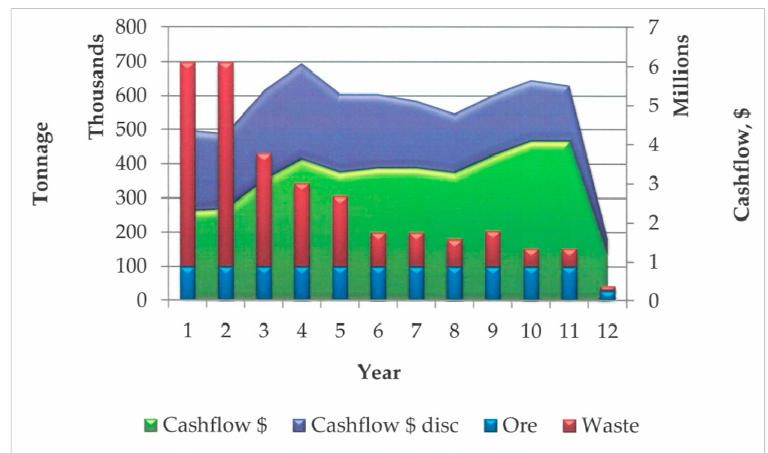
Figure 7. Tonnage of ore and waste and discounted and undiscounted cashflows for the life of the operation.